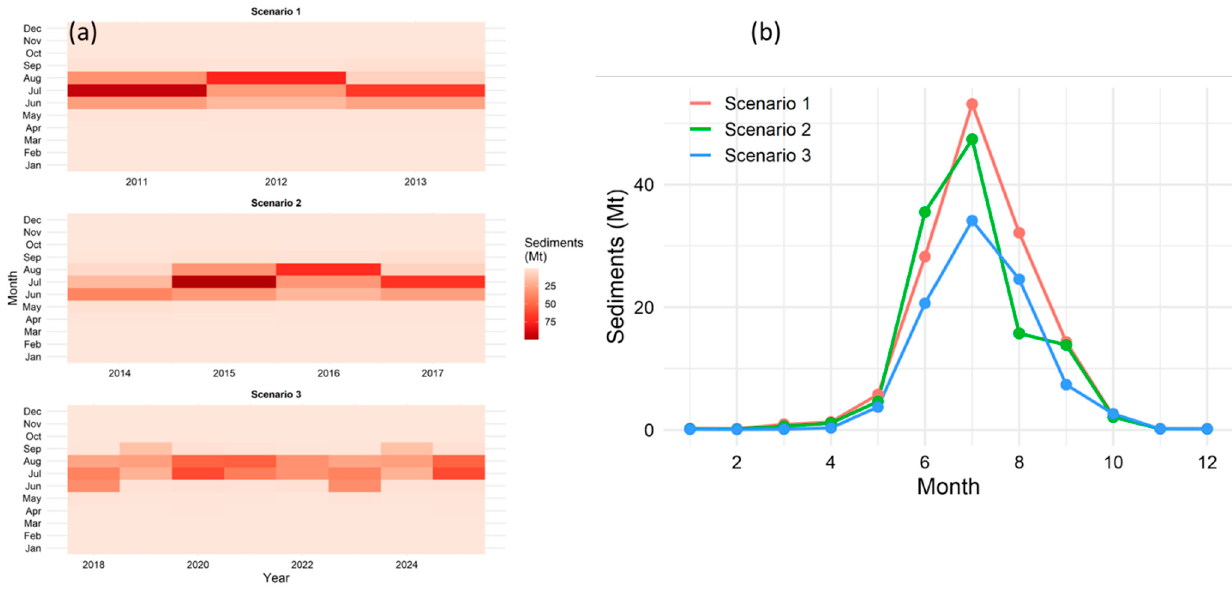
Figure 9. Sediment’s flow comparison between the first (2013), second (2017), and third (2025) scenarios. ( a ) Monthly time series and ( b ) monthly averages for all scenarios.